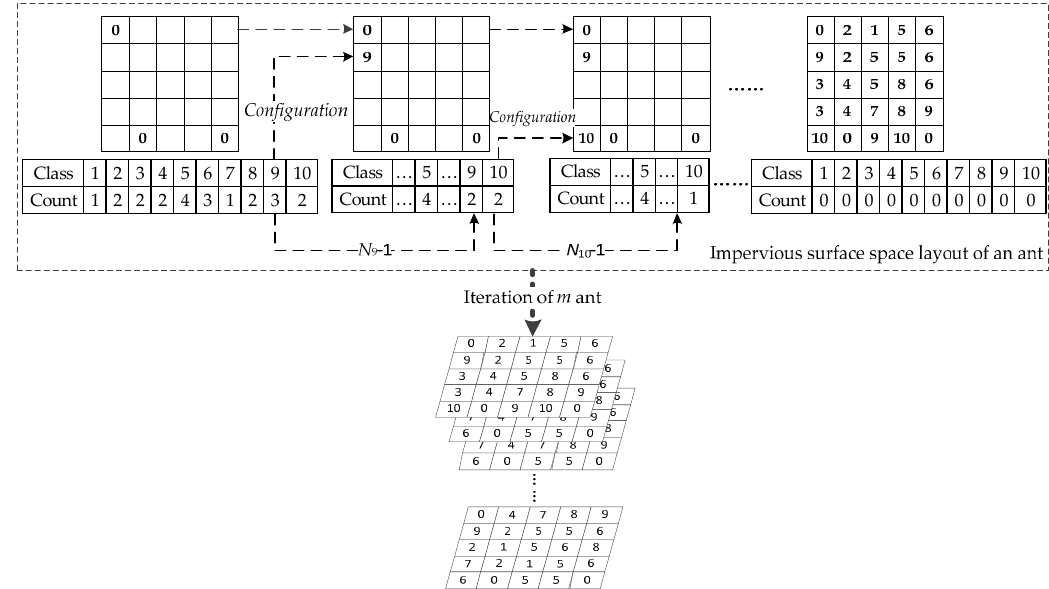
Figure 3. Configuration process of impervious surfaces.